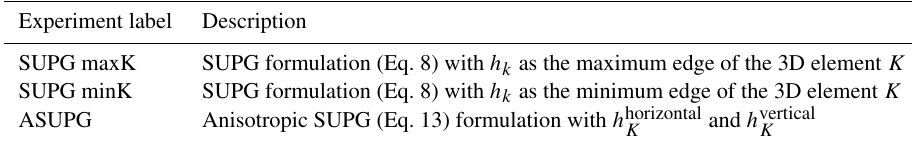
Table 2. List of employed stabilization approaches. Experiment